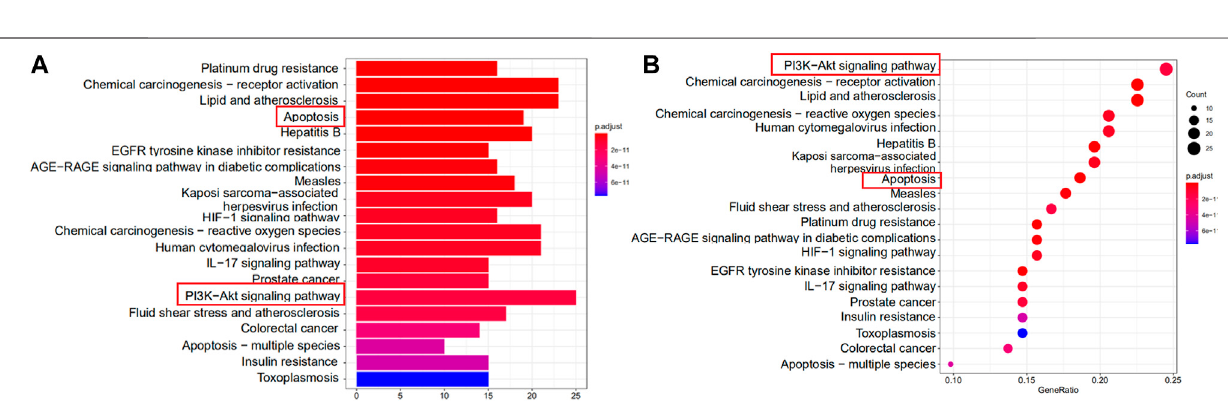
FIGURE 3 | KEGG functional enrichment analysis represented in bar chart (A) and bubble diagram (B)